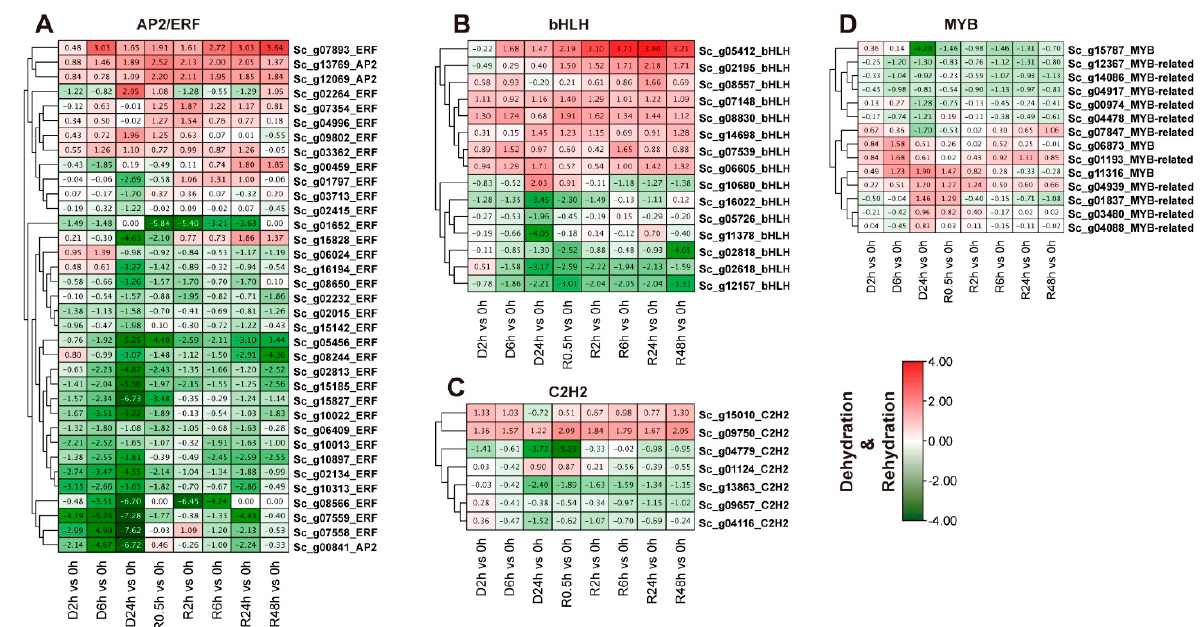
Figure 8. Expression profiles of the top four TF family genes were analyzed using hierarchical clustering in different time-series of dehydration-rehydration stress. FPKM values of representative transcript levels of TF members. The standardized expression data was used to generate a heatmap with hierarchical clustering based on the Manhattan correlation with average linkage using the MeV software package. Expression levels of ( A ) AP2/ERF, ( B ) bHLH, ( C ) MYB, ( D ), C2H2-zinc finger genes under dehydration stress at 2, 6, and 24 h, and rehydration conditions at 0.5, 2, 6, 24 and 48 h. The color scale below the heatmap represents the expression pattern; green shows down-regulated and red shows up-regulated genes. The heatmap shows the change of the average log2 (fold-change) of each transcript.